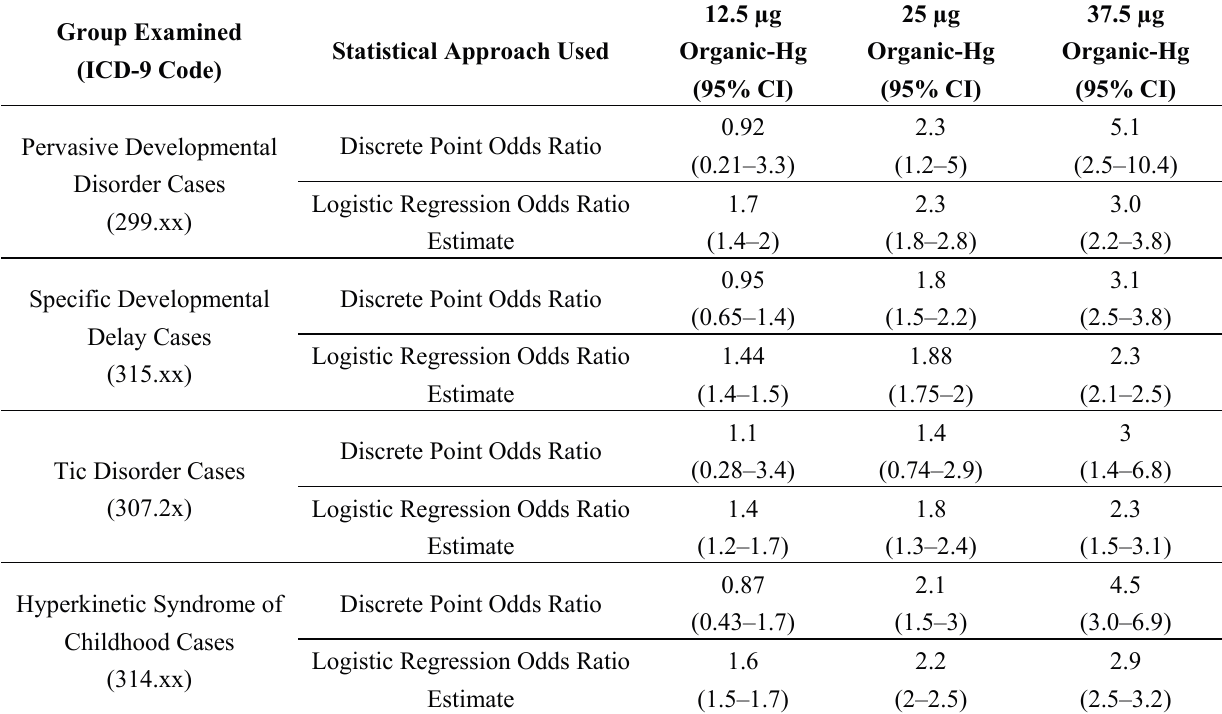
Table 5. A summary of exposure to organic-Hg from thimerosal-containing hepatitis B vaccine administration within the first six months of life for the cases diagnosed with a studied ND and the controls by both the discrete-point odds ratio estimates and the logistic regression odds ratio